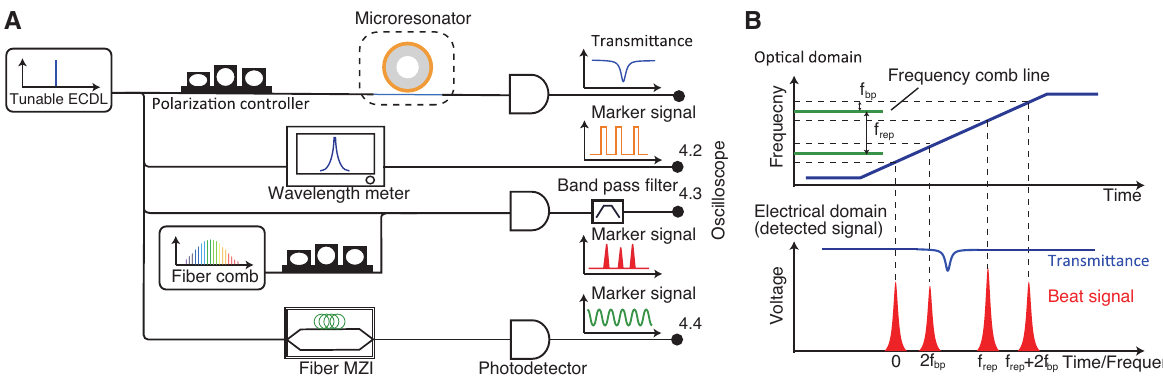
Figure 10: Schematics of various dispersion measurement methods. (A) Schematic of the setup used for the microresonator dispersion measurement. Both the resonator transmittance and calibration marker are recorded simultaneously with a multi-channel oscilloscope. The paths of 4.2, 4.3, and 4.4 can be independently used for dispersion measurements, but all the signals in the experiment were observed for comparison. ECDL, external cavity diode laser; MZI, Mach-Zehnder interferometer. (B) Operating principle of the mode-locked frequency comb-based method. The scanning laser generates beat notes with stabilized fiber comb lines, and the beat signals filtered with a band-pass filter calibrate the time axis to frequency axis.